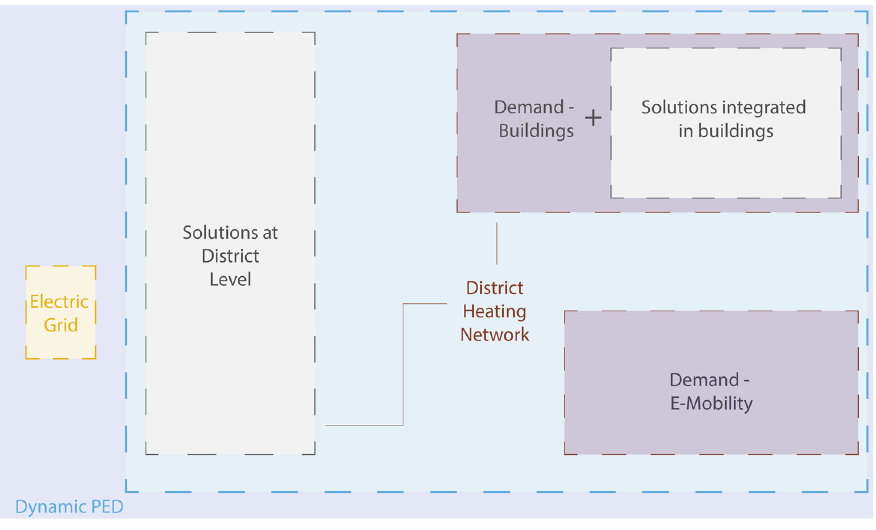
Figure 2. Dynamic PED. Figure 2. Dynamic